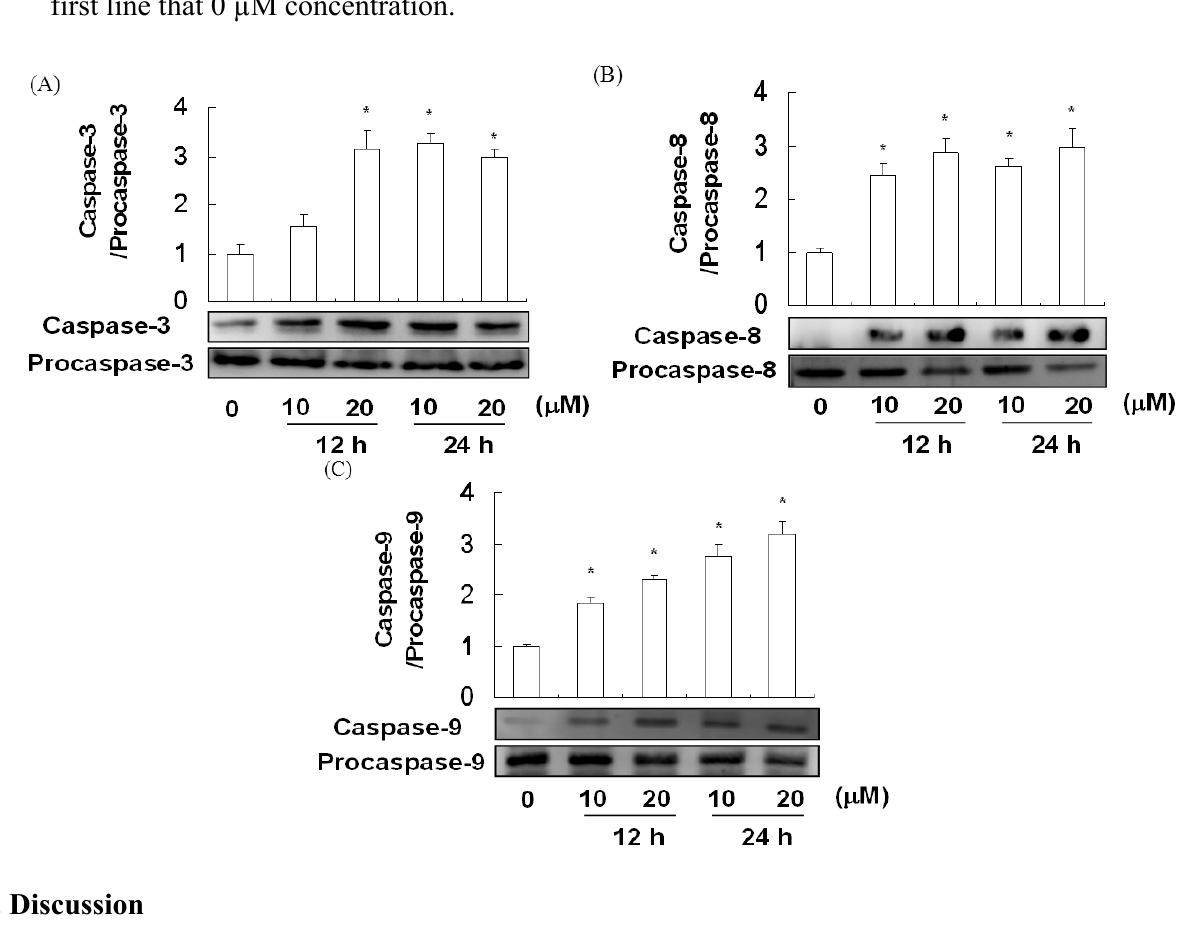
Figure 6. Caspases expression of A549 cells treating with davallic acid at various concentrations for 12 h and 24 h, respectively. ( A ) Caspase-3; ( B ) caspase-8; ( C ) and caspase-9. Results are expressed as mean ± SD (n = 3). * p < 0.05 was compared with the first line that 0 µM